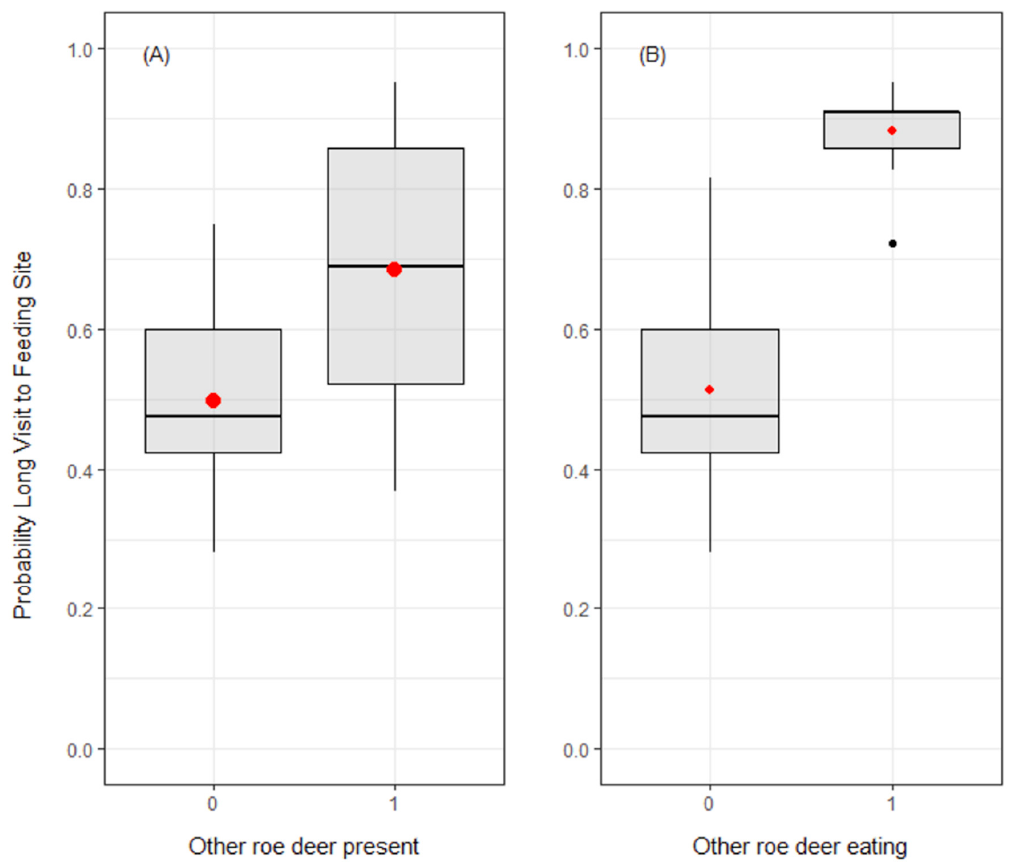
Figure 3. Predictive boxplots reporting the probability to detect a long visit to a feeding site in function of the presence of other roe deer at the feeding site (panel A ) and of the eating activity of the other roe deer at the feeding site (panel B ). Red points denote the predicted mean values; the black dot denotes an outlier.